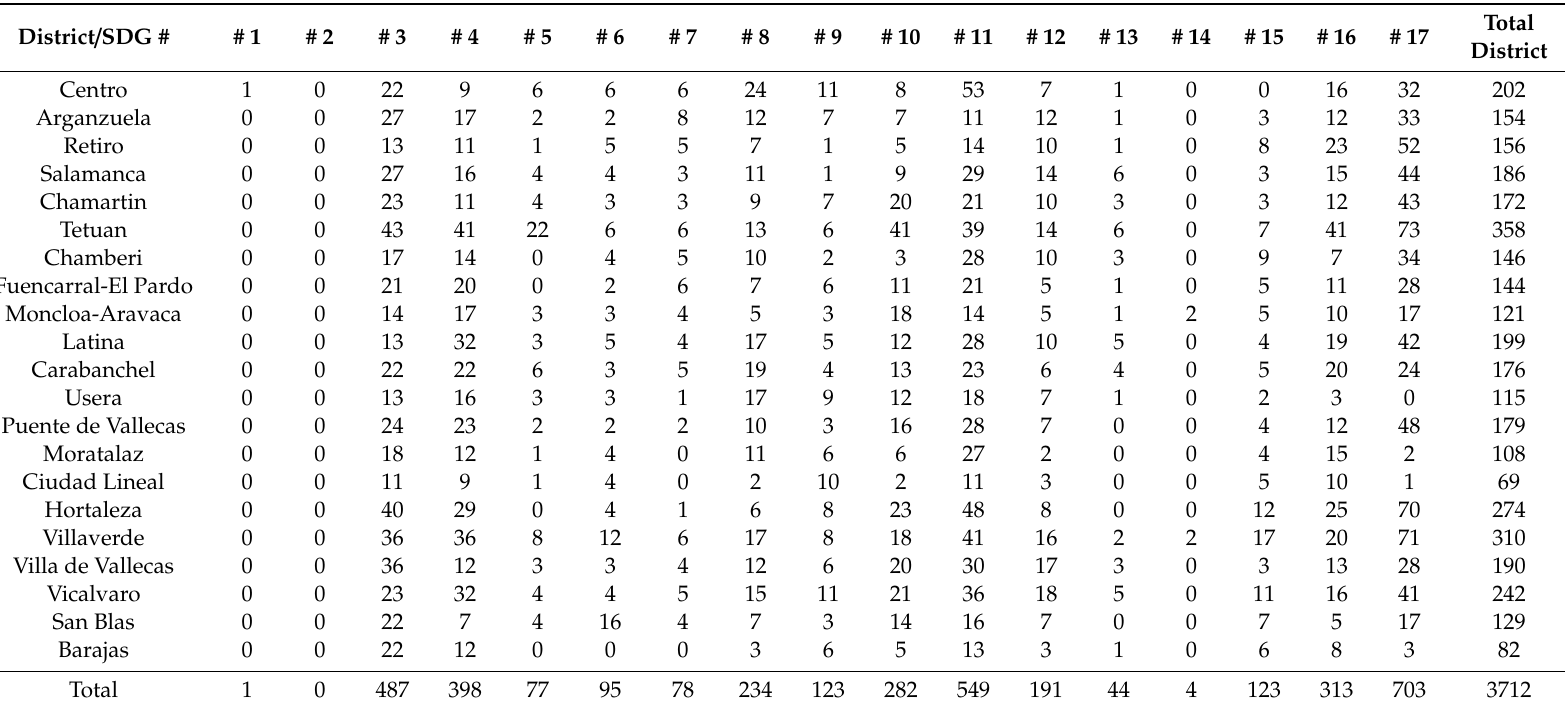
Table 3. Distribution of actions among the SDGs (Source: